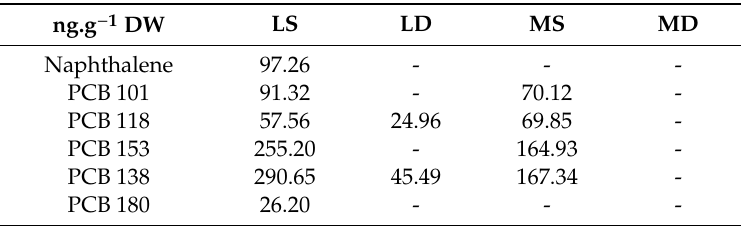
Table 2. PAH and PCBs concentrations in liver (L) and muscle (M) in Seine estuary (S) and Douarnenez bay (D). (one sample: a pool of five fish